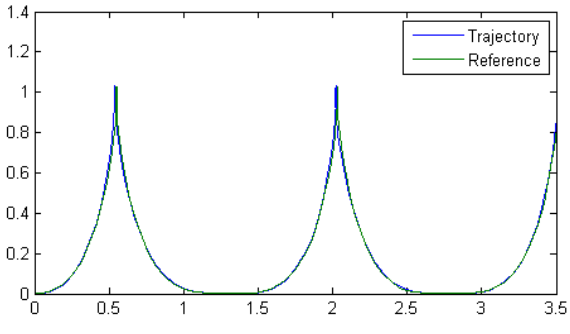
Figure 14. Best simulation of BA algorithm.